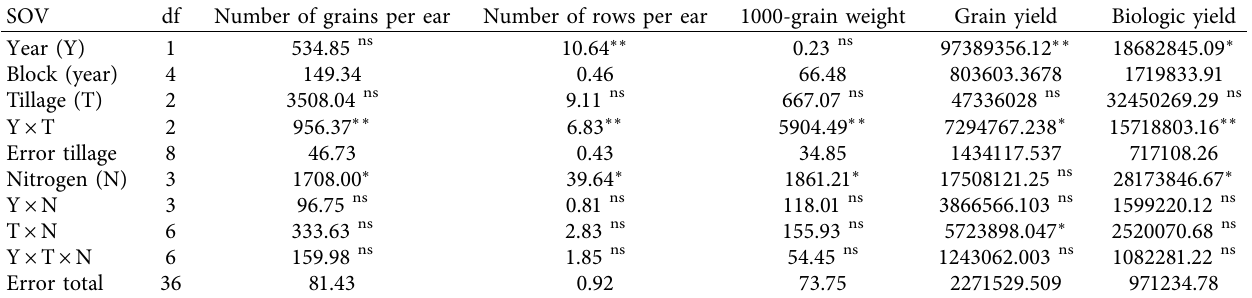
Table 4: Analysis of variance of yield and yield components of maize in different levels of tillage and nitrogen in two years. SOV